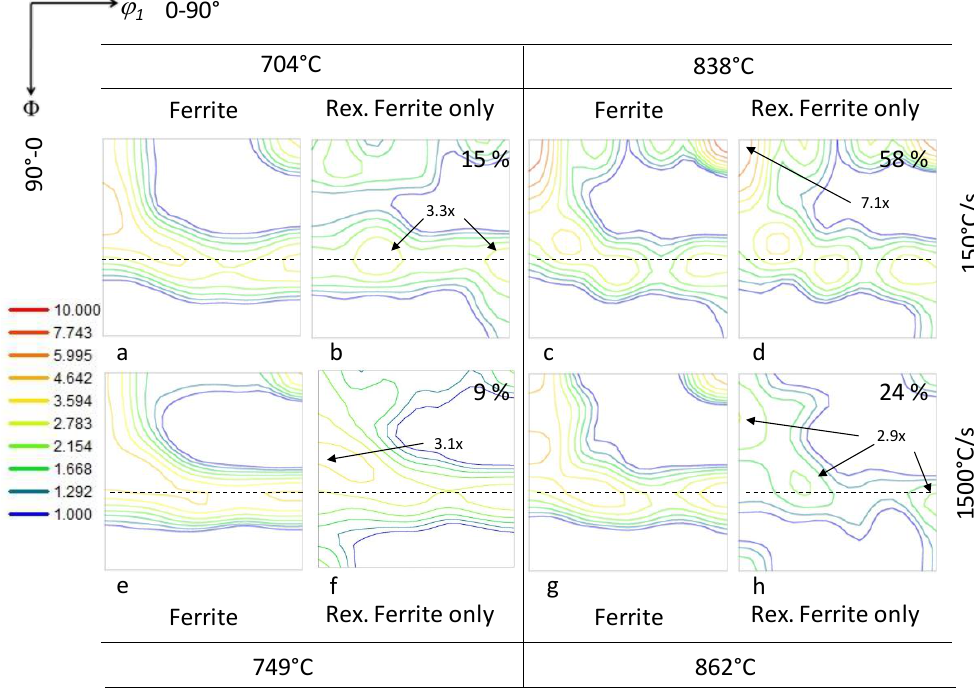
Figure 4. ODF of ferrite at ϕ 2 = 45° from samples heated at 150 °C/s ( a – d ) and 1500 °C/s ( e – h ). ( a ) and ( b ) correspond to peak temperature of 704 °C; ( c , d ) to 838 °C; ( e ) and ( f ) to 749 °C and ( g ) and ( h ) to 862 °C. ( a , c , e , g ) correspond to recrystallized and non-recrystallized ferrite, whereas ( b , d , f , h ) correspond to recrystallized ferrite. Numbers in ( b , d , f , h ) indicate the recrystallized ferrite fraction. Dashed line indicates the ideal position of {111}<uvw> ND fiber. For color images please see the online version of the paper.